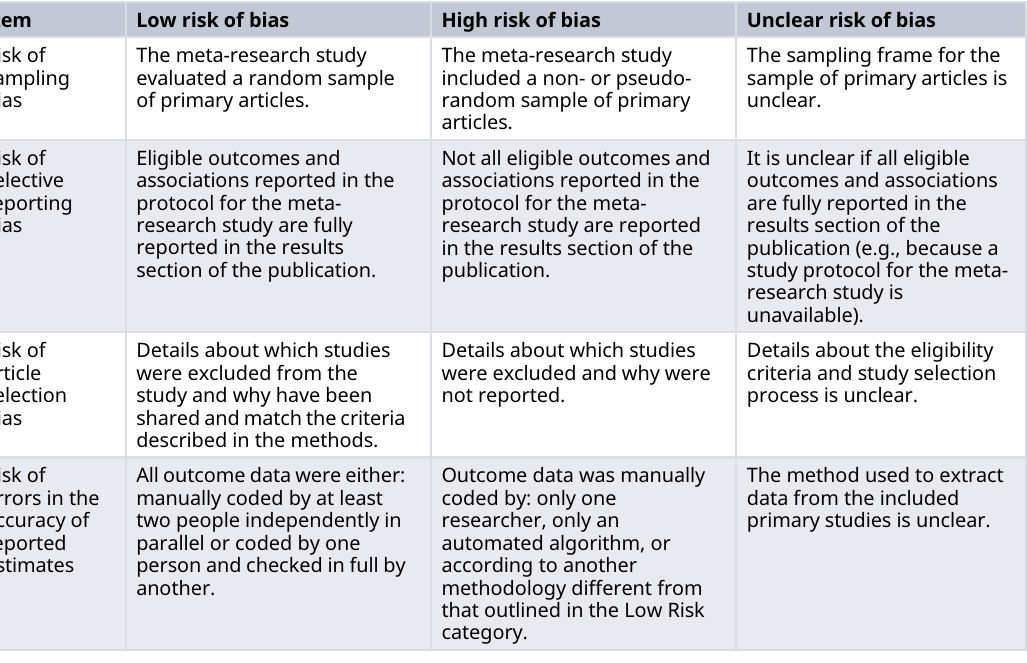
Table 1. Risk of bias